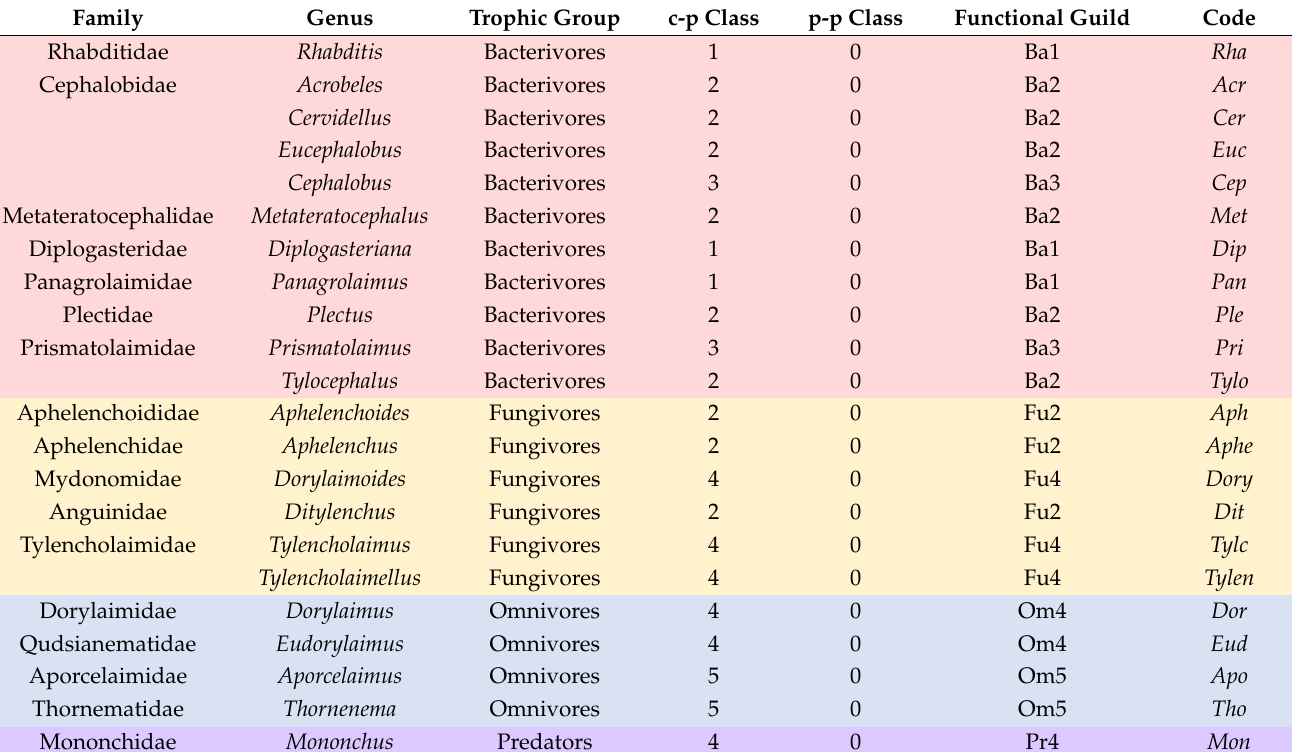
Table 2. Main nematode taxa identified from wheat-growing areas in southern